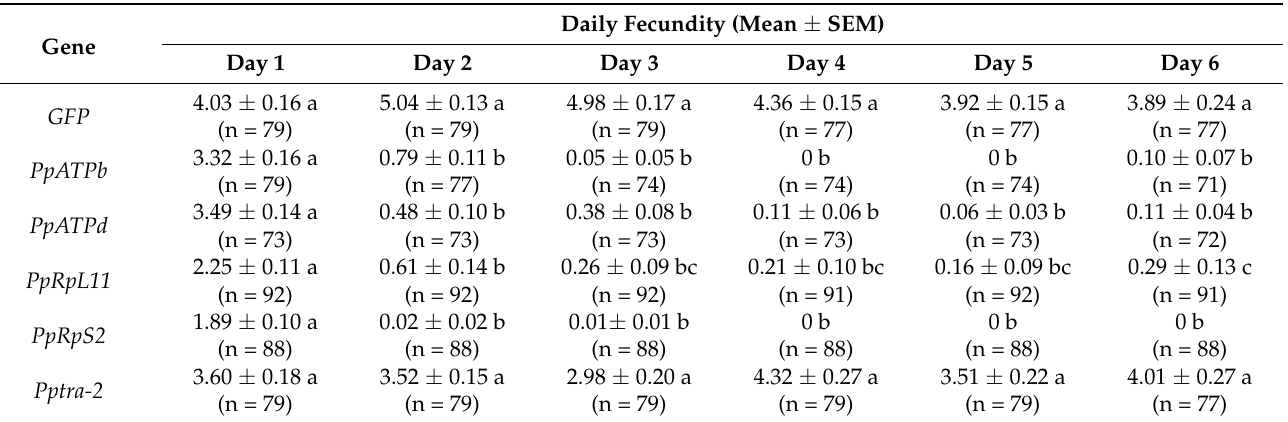
Means within a row followed by different letters are significant differences across each day (SNK tests: p < 0.05).